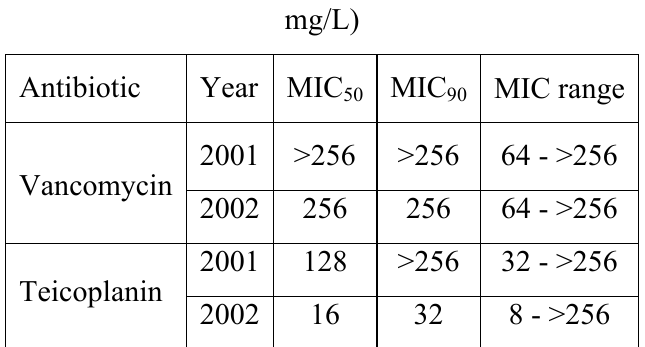
Table 13. MIC and MIC of the vanA positive E. faecium isolates (MIC given 50 90